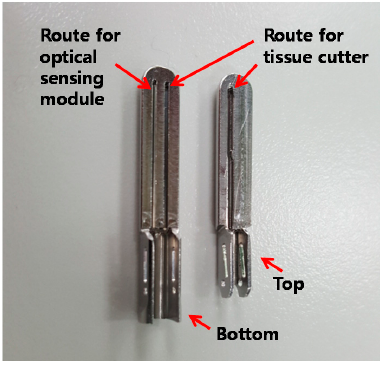
Figure 2. IGLaST head with the route for the optical sensing module.